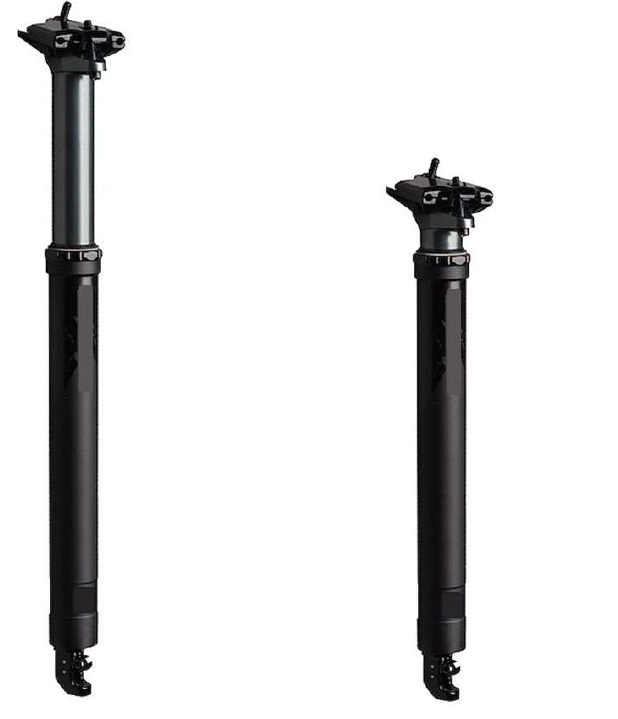
Figure 11. Example of a drop seatpost with original ( left ) and reduced ( right ) length/height.